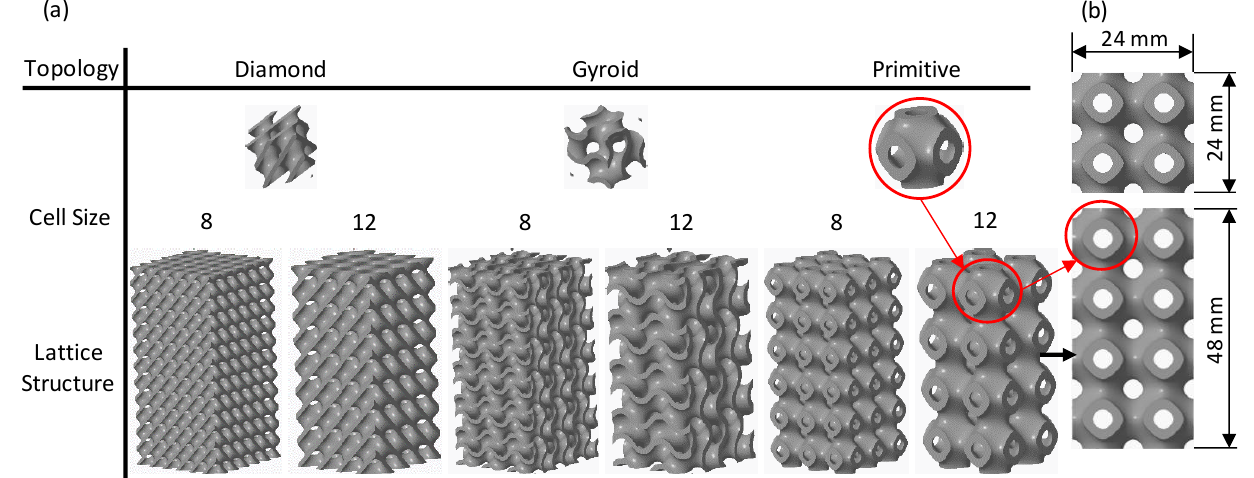
Figure 1. TPMS Lattice structures at 30% RD: ( a ) cell topologies, cell sizes, and the associated lattice structures and ( b ) lattice structure dimensions. Table 1. Values of wall thickness parameter ( t ) for each TPMS topology at designed RDs and lengths ( l ). Cell